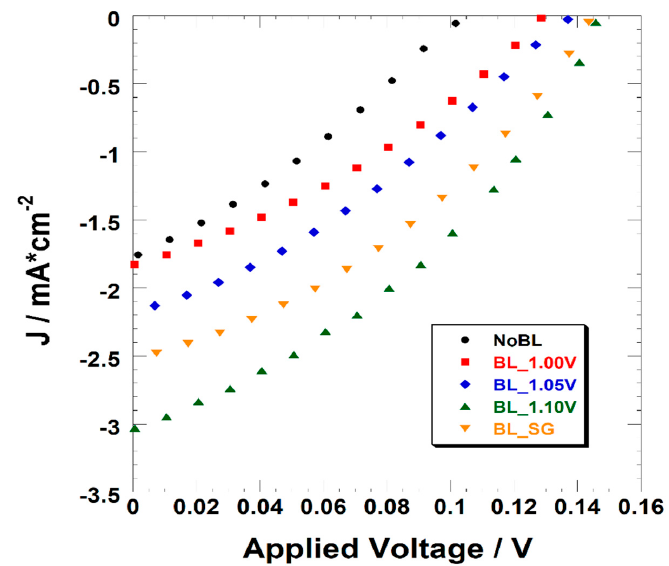
Figure 2. J - V Curves of Dye-Sensitized Solar Cells made with or without (black dots) a blocking layer. The latter is electrochemically deposited at 1.00 V (red squares), 1.05 V (blue diamonds), 1.10 V (green triangles), or deposited by sol-gel (orange triangles).